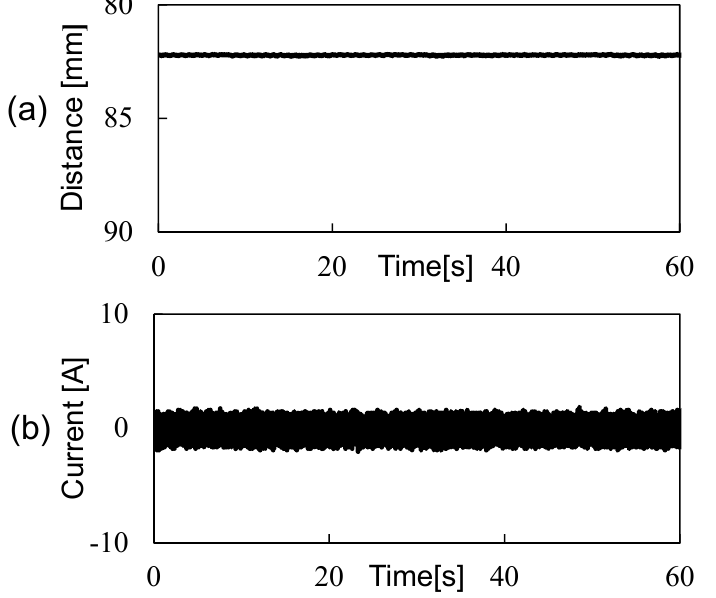
Figure 15. Relationships between ( a ) distance and time and between ( b ) current and time in the case of persistent current.